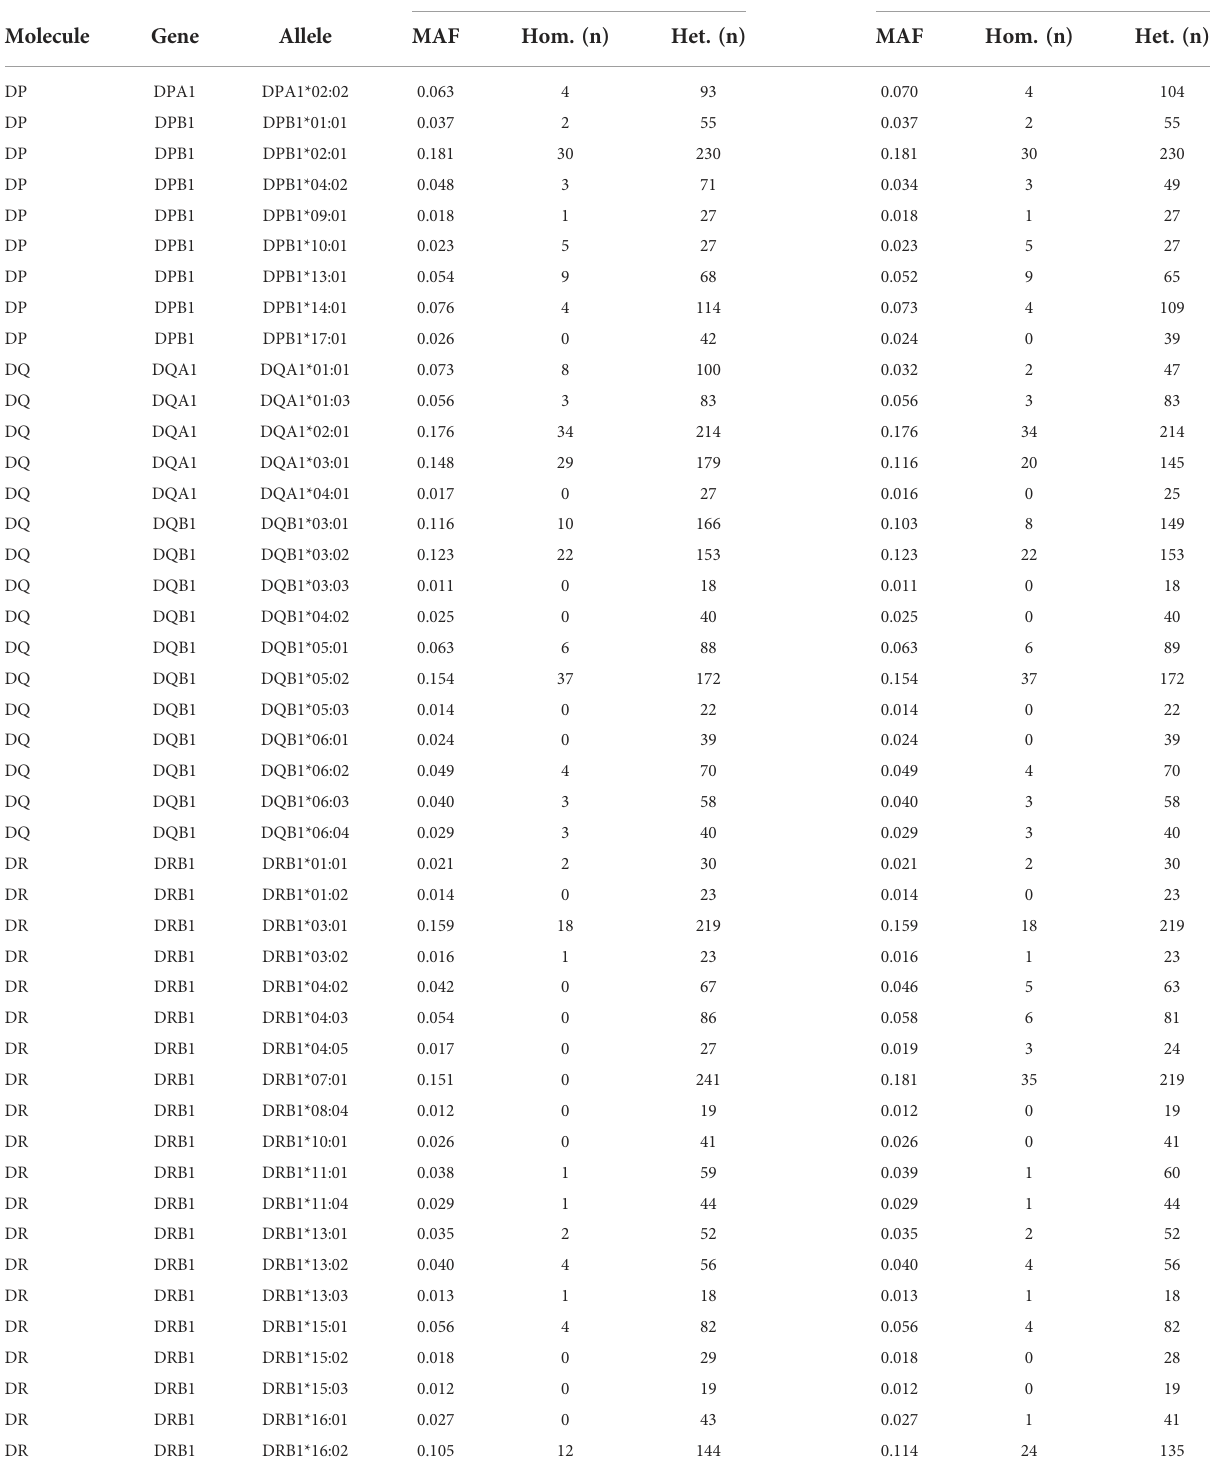
TABLE 3 HLA class II alleles in the Qatar Biobank cohort (n = 800) considered for association studies. HLA*LA HLA-HD Molecule Gene Allele MAF Hom.